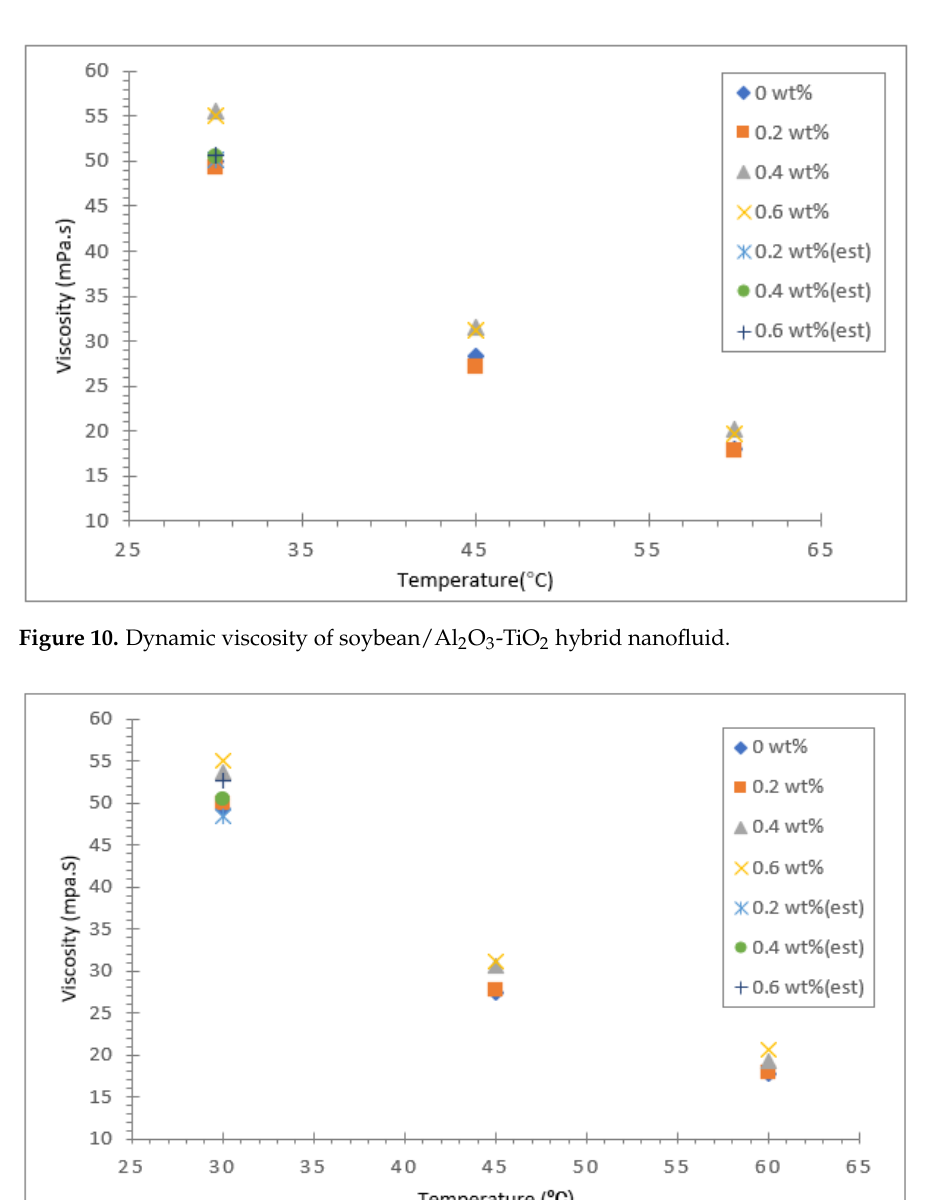
Figure 10. Dynamic viscosity of soybean/Al 2 O 3 -TiO 2 hybrid nanofluid.